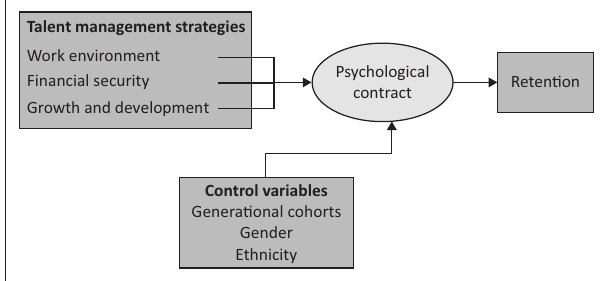
FIGURE 1: Conceptual model for the